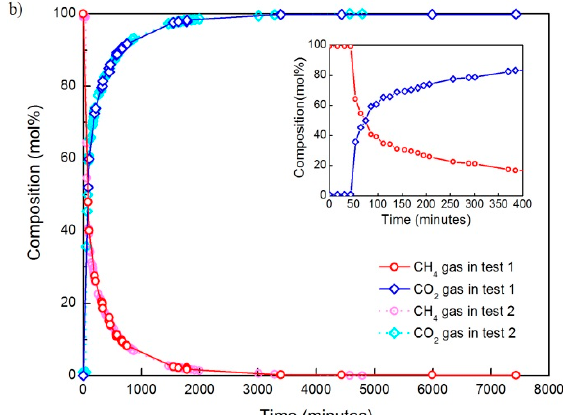
Figure 3. Changes in the gas phase composition as a result of the continuous gas flow after the exchange from CH 4 gas to CO 2 gas: ( a ) real-time Raman spectra monitoring, and ( b ) the relative molar composition of the gas phase over time in two separate tests. For a better overview, the time axis in Figure 3a is displayed value-independent.